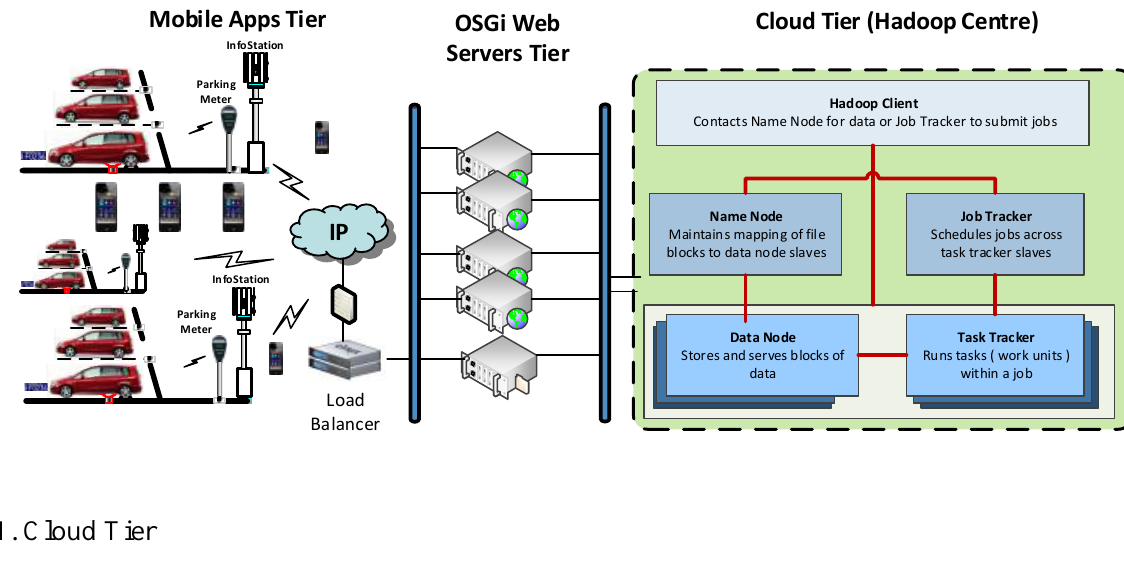
Figure 7. A high-level view of a cloud-based car parking system’s application